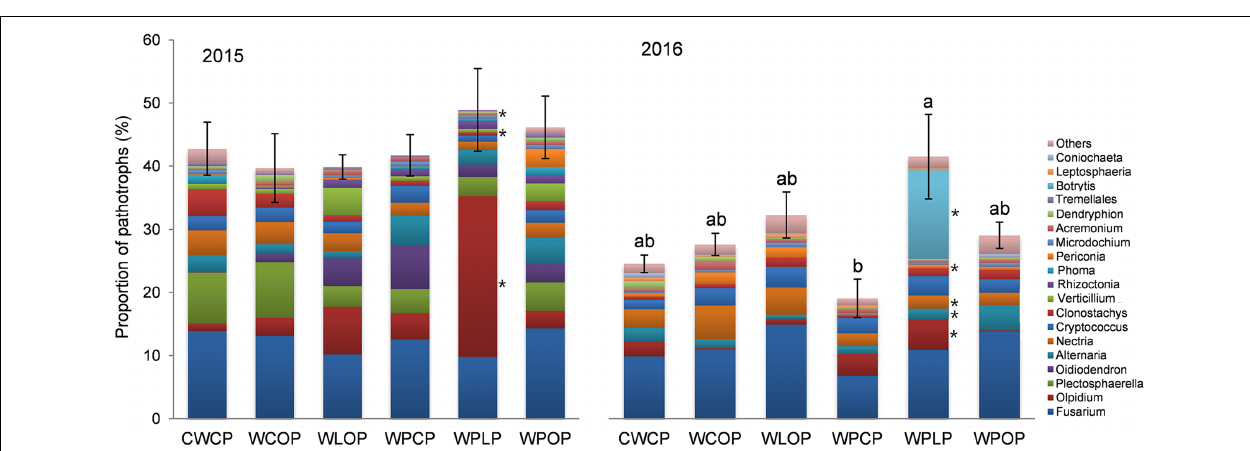
nutrients was observed. With few exceptions,